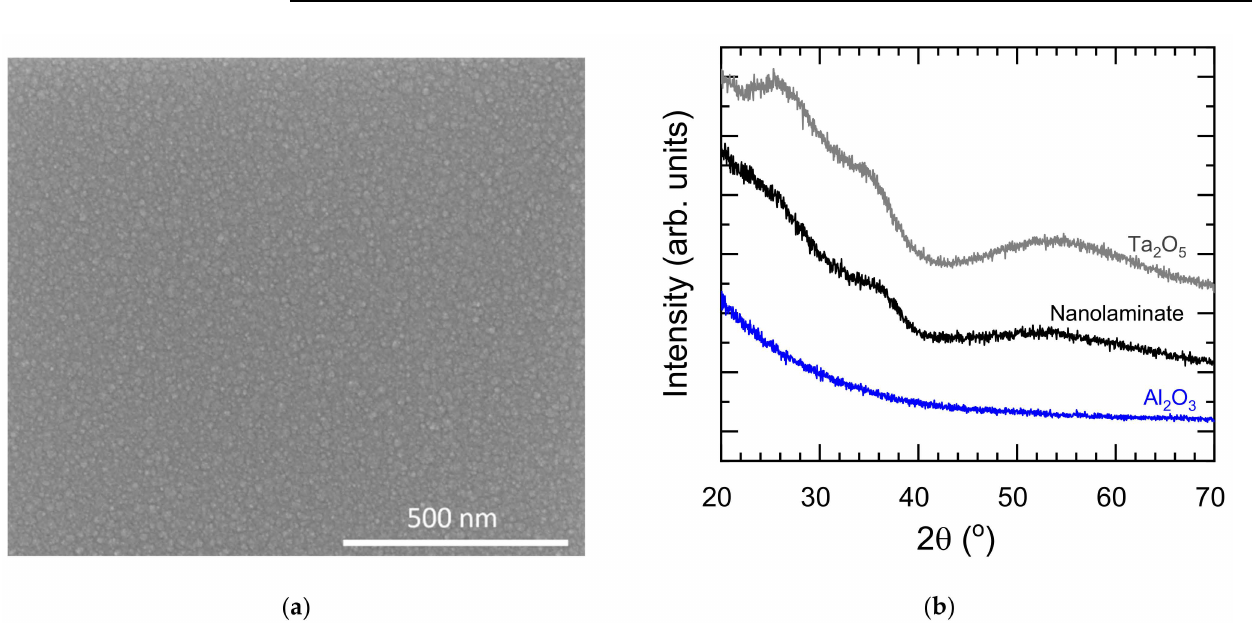
Figure 3. ( a ) SEM image of the surface of as-deposited Al 2 O 3 /Ta 2 O 5 /Al 2 O 3 /Si laminate, ( b ) GIXRD diffractograms of Al 2 O 3 -Ta 2 O 5 nanolaminate and reference Ta 2 O 5 and Al 2 O 3